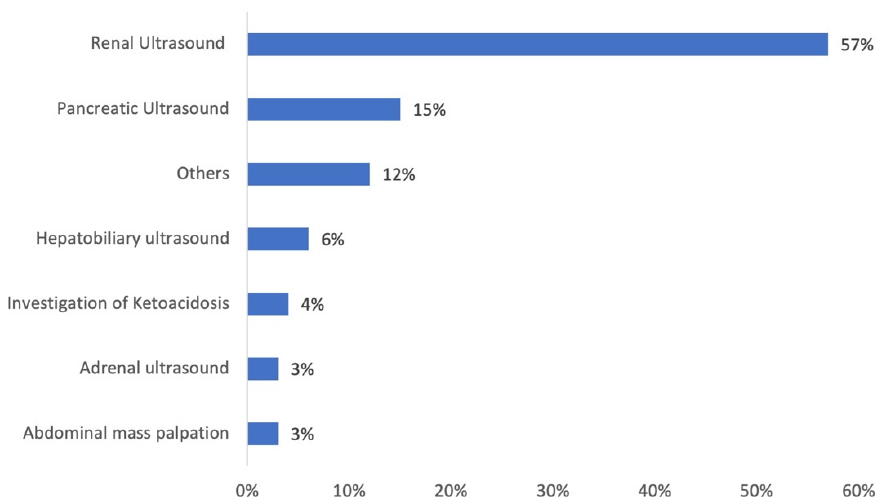
Figure 2. Main reasons for performing abdominal ultrasound in cats showing adrenomegaly. “Others” category consists of a percentage of 1.5% each, detailing: abdominal pain, lymph node investigation, uterine ultrasound, weight loss, suspected gastrointestinal foreign body, acute vomiting, chronic vomiting, and medical exploration of insulin resistance.